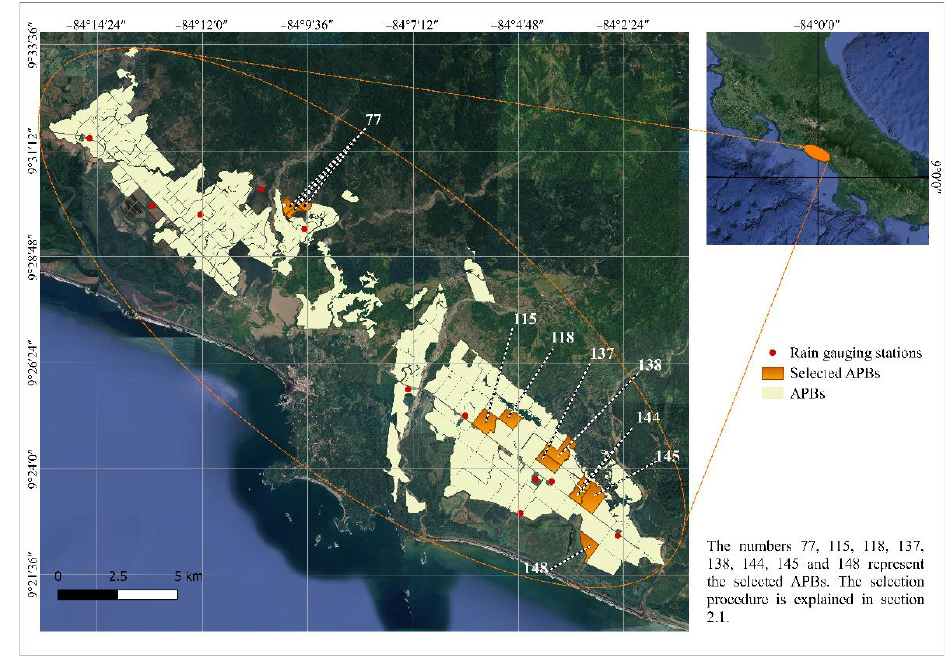
Figure 1. Location of oil palm plantation under study. Oil palm plantation area (yellow and orange APBs) of which eight APBs were selected (orange APBs) and the position of the rain gauging stations (red dots).